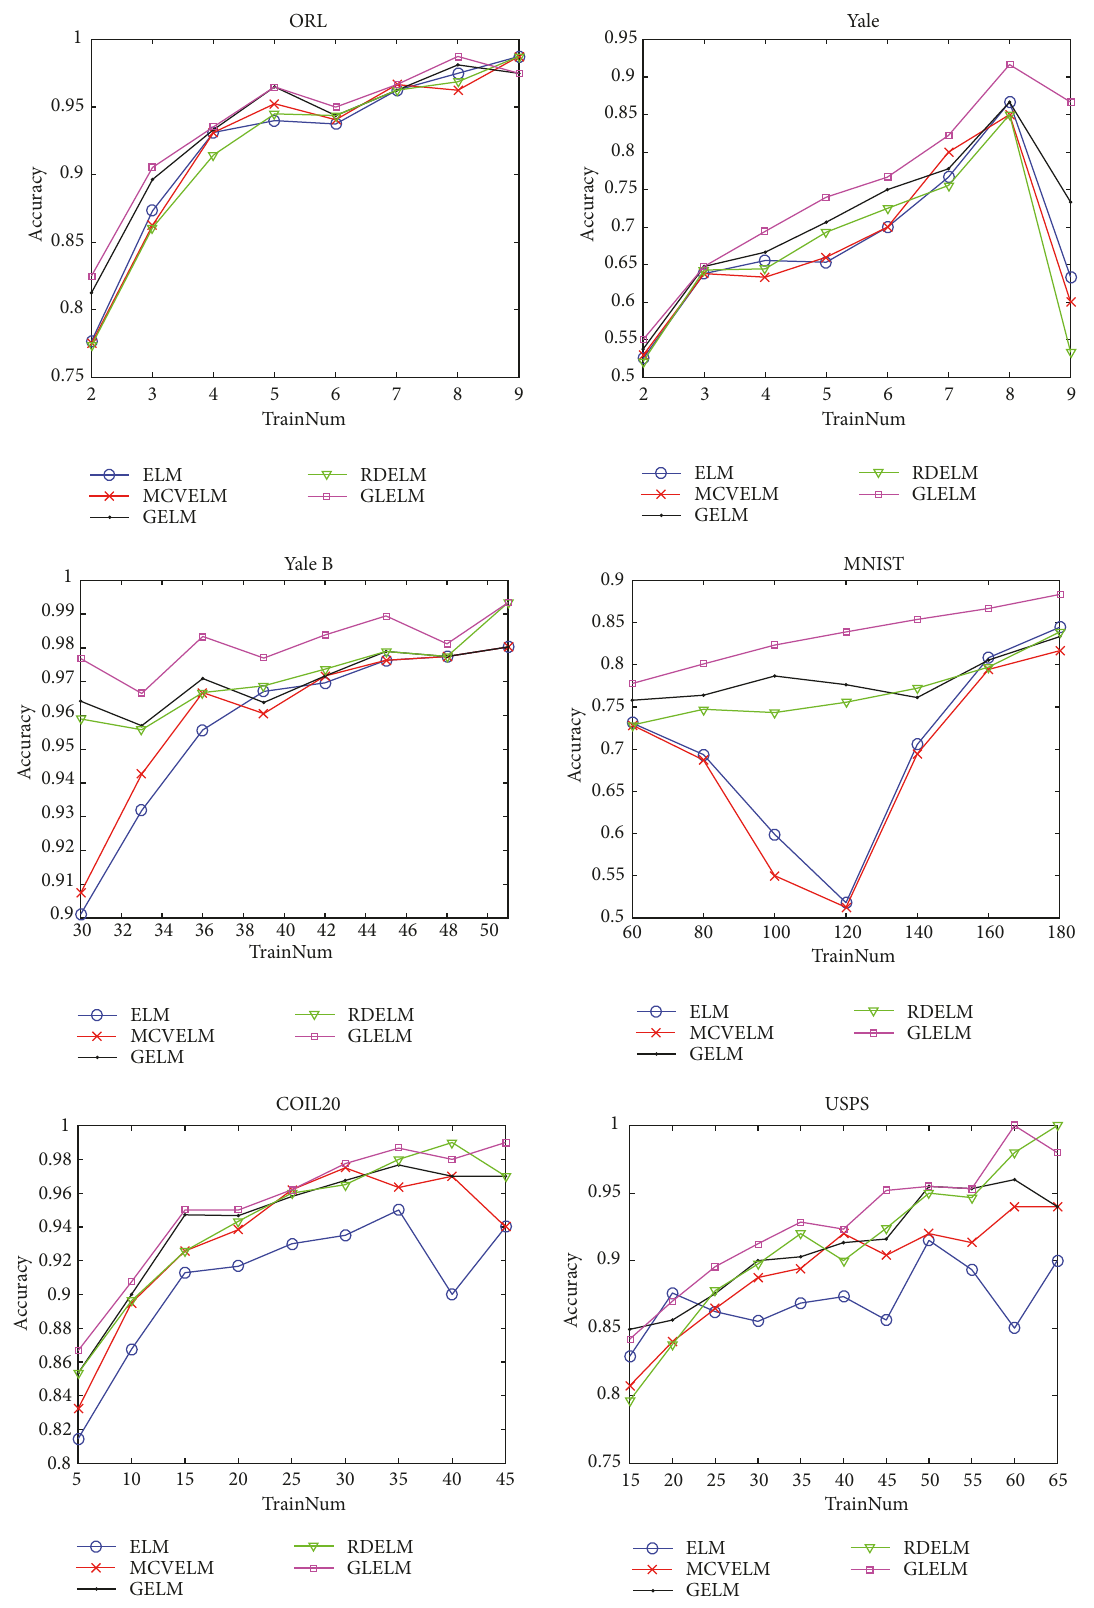
Figure 2: Recognition rate curves of different ELM algorithms on image datasets ORL, Yale, Yale B, COIL20, MNIST, and